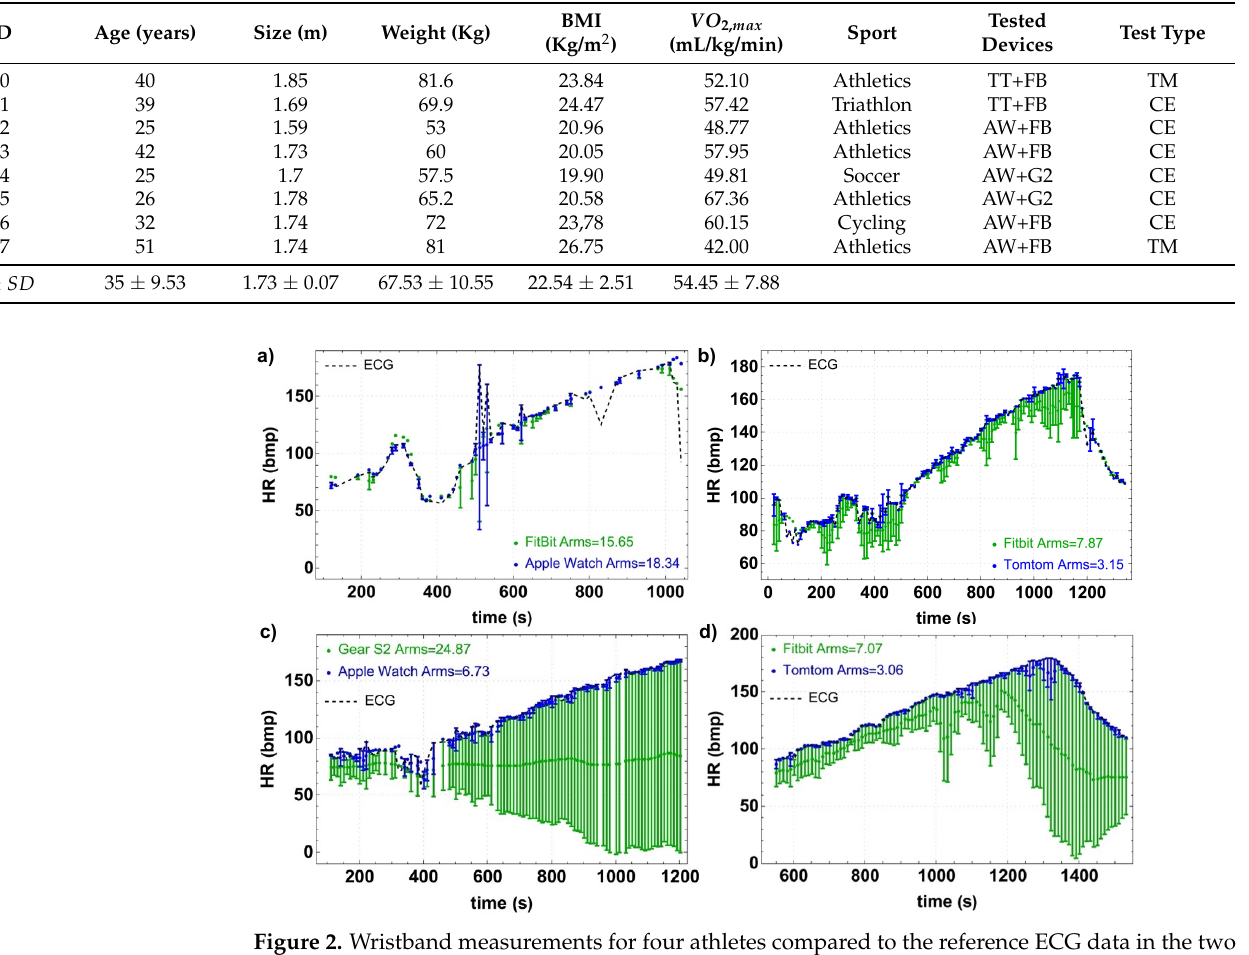
Table 1. Anthropometric characteristics of the participants, their practiced sports, tested devices, and type of test. TM: treadmill; CE: cycle ergometer.